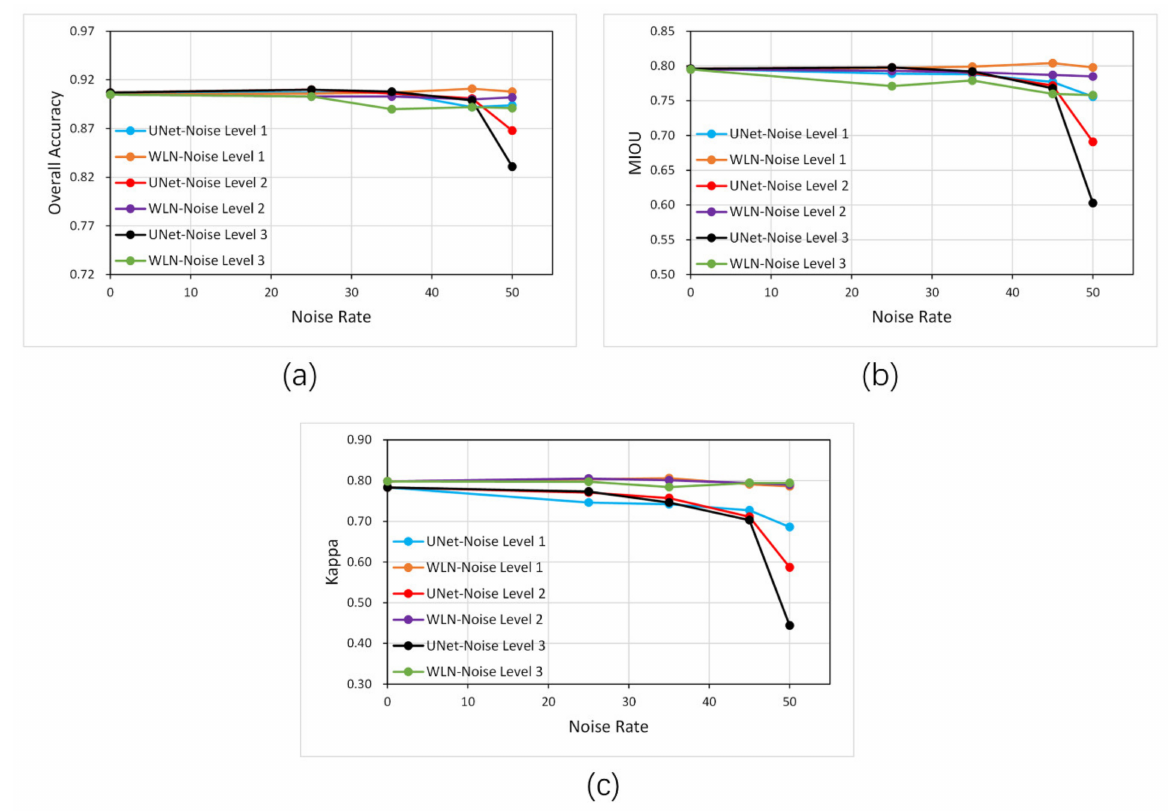
Figure 9. Accuracy plots of different eroded noise levels on the test set. ( a ) the overall accuracy, ( b ) MIOU and ( c )